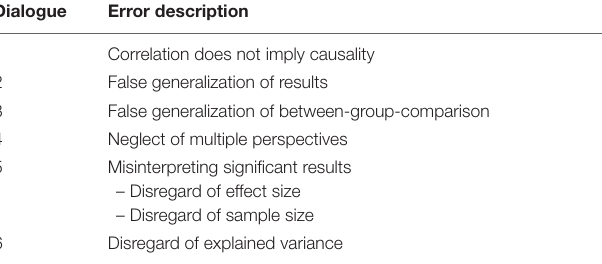
TABLE 7 | Argumentation errors covered in the learning intervention in Study 2.